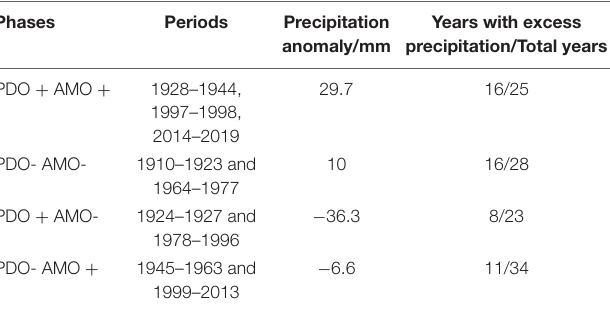
TABLE 1 | The periods of different PDO and AMO phases, the corresponding average precipitation in the flood season, and the years with excess precipitation during 1910–2019.